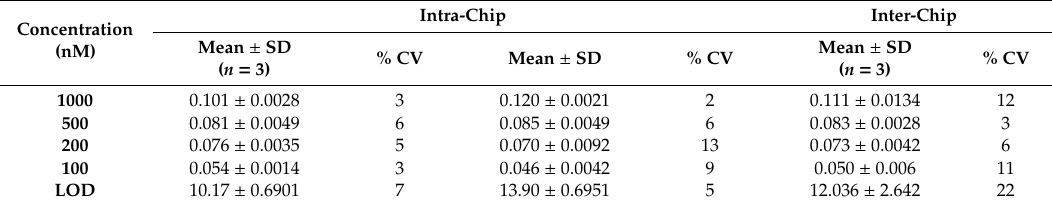
Table A2. Variability of the SPR sensor signal intra- and inter-assays for mtLSU rRNA detection using PPRH probe. The mean ± SD are from three replicates performed in the same or di ff erent biofunctionalized sensor chips, respectively.